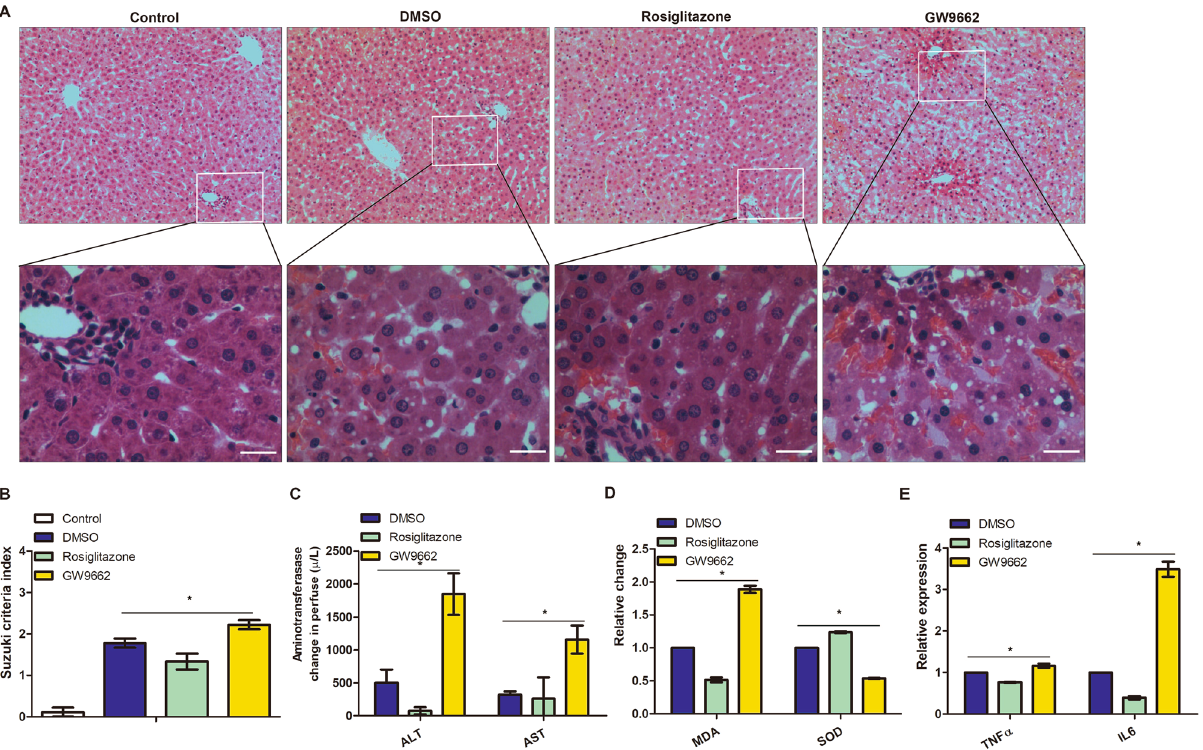
Figure 4. Effect of PPARγ on functions of livers from donation of cardiac death under air-oxygenated normothermic machine perfusion (NMP) (*denotes significant differences among DMSO, Rosiglitazone and GW6471, P < 0.05, n = 4). ( A ) Histology (haematoxylin and eosin staining, original magnification × 200, and scale bars 50 μm); ( B ) Suzuki sinusoidal injury scores of the perfused livers on a scale from 0 to 4; ( C ) Changes in levels of ALT and AST in NMP perfusate; ( D ) Relative changes in MDA level and SOD activity in the perfused livers; ( E ) Relative levels of TNF-α and IL-6 in the perfusate using